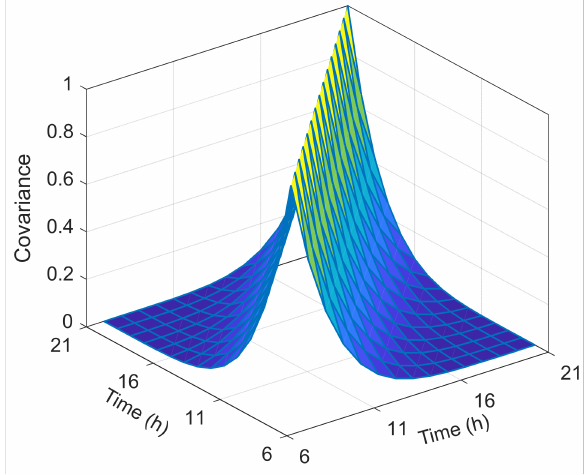
Figure 8. Relationship between covariance and time